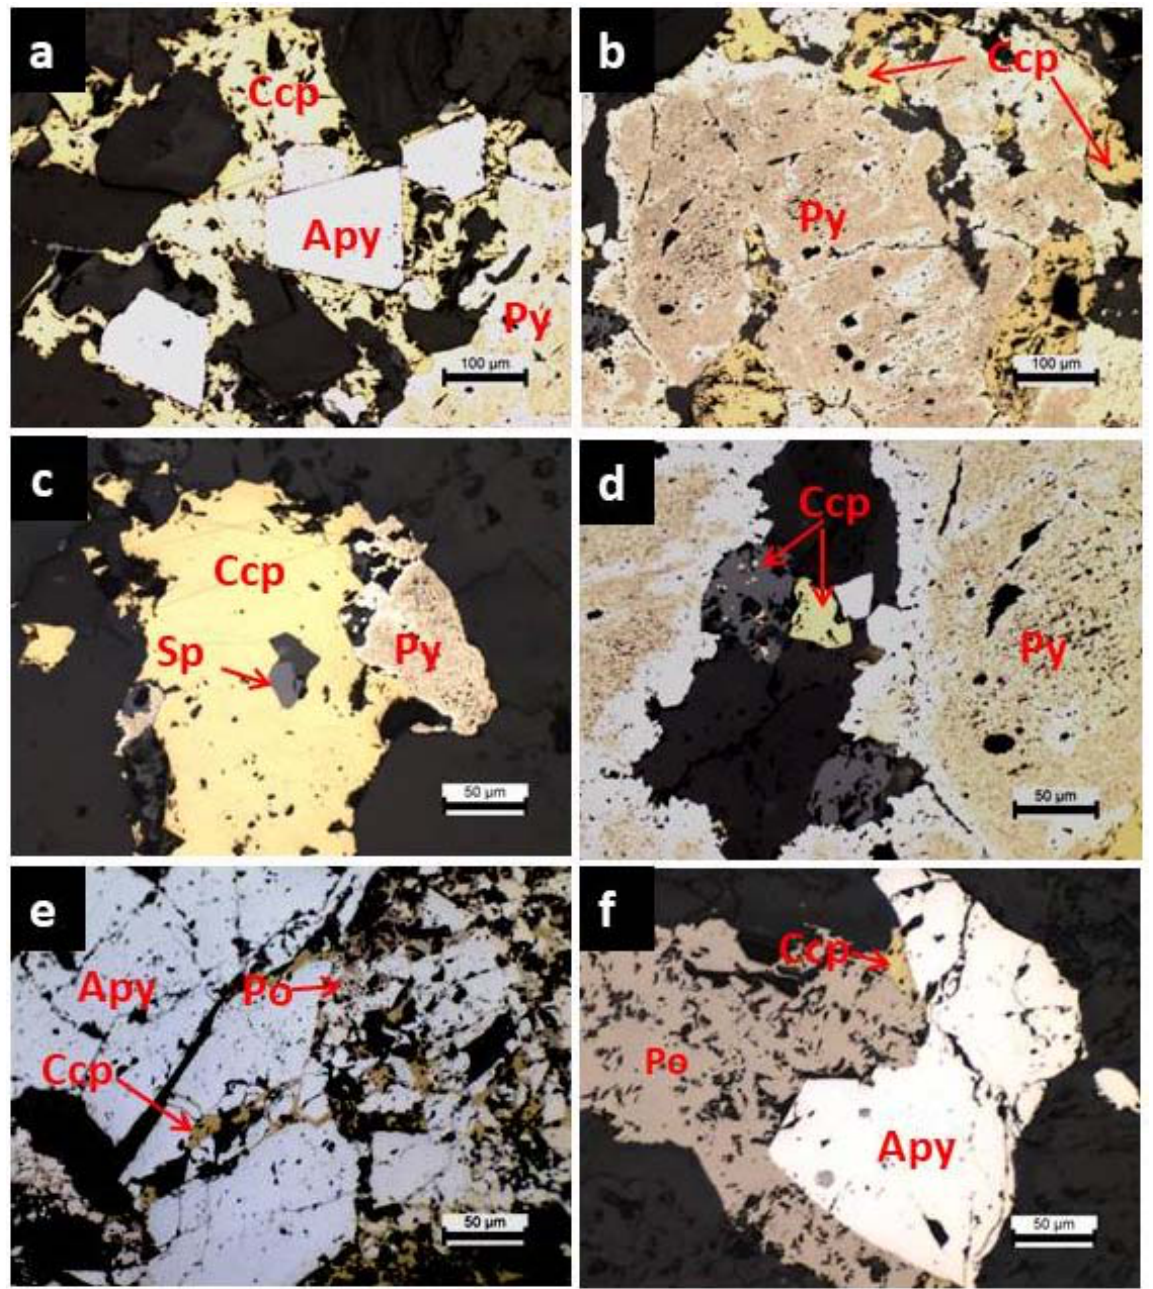
Figure 7. Photomicrographs showing association of different generations of mineral assemblages and textural characteristics ( a ) euhedral arsenopyrite within chalcopyrite grains as disseminated mineralization; ( b , c ) replacement of chalcopyrite along the fractures of pyrite; laths of chalcopyrite within pyrite; ( d ) a small grain of sphalerite within chalcopyrite and pyrite present at the outer rim of chalcopyrite; ( e ) fractured filled pyrrhotite and chalcopyrite in arsenopyrite; ( f ) coexistence of pyrrhotite-chalcopyrite and arsenopyrite in the mineralized quartz carbonate veins. (Apy: Arsenopyrite, Ccp: Chalcopyrite, Po: Pyrrhotite, Py: Pyrite and Sp: Sphalerite).